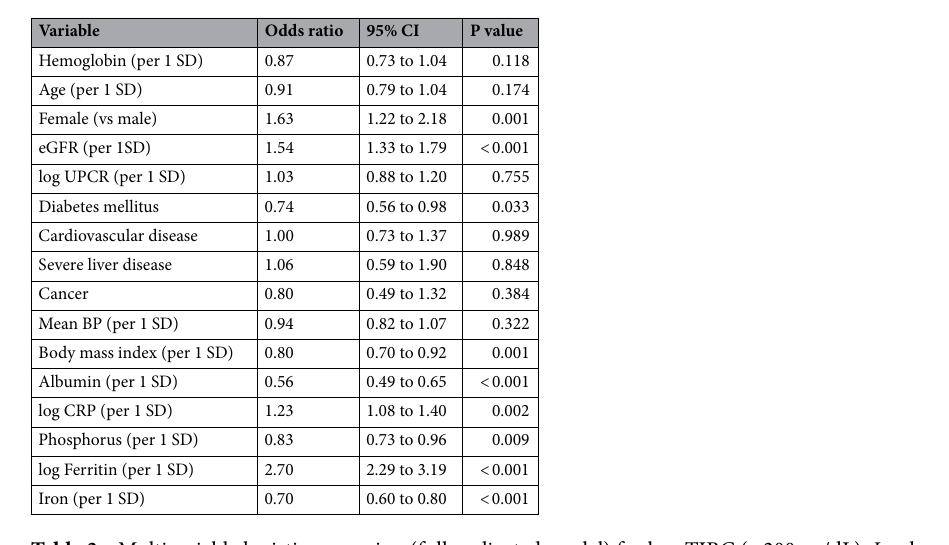
Table 3. Multivariable logistic regression (fully-adjusted model) for low TIBC (< 200 μg/dL). Log log- transformation.